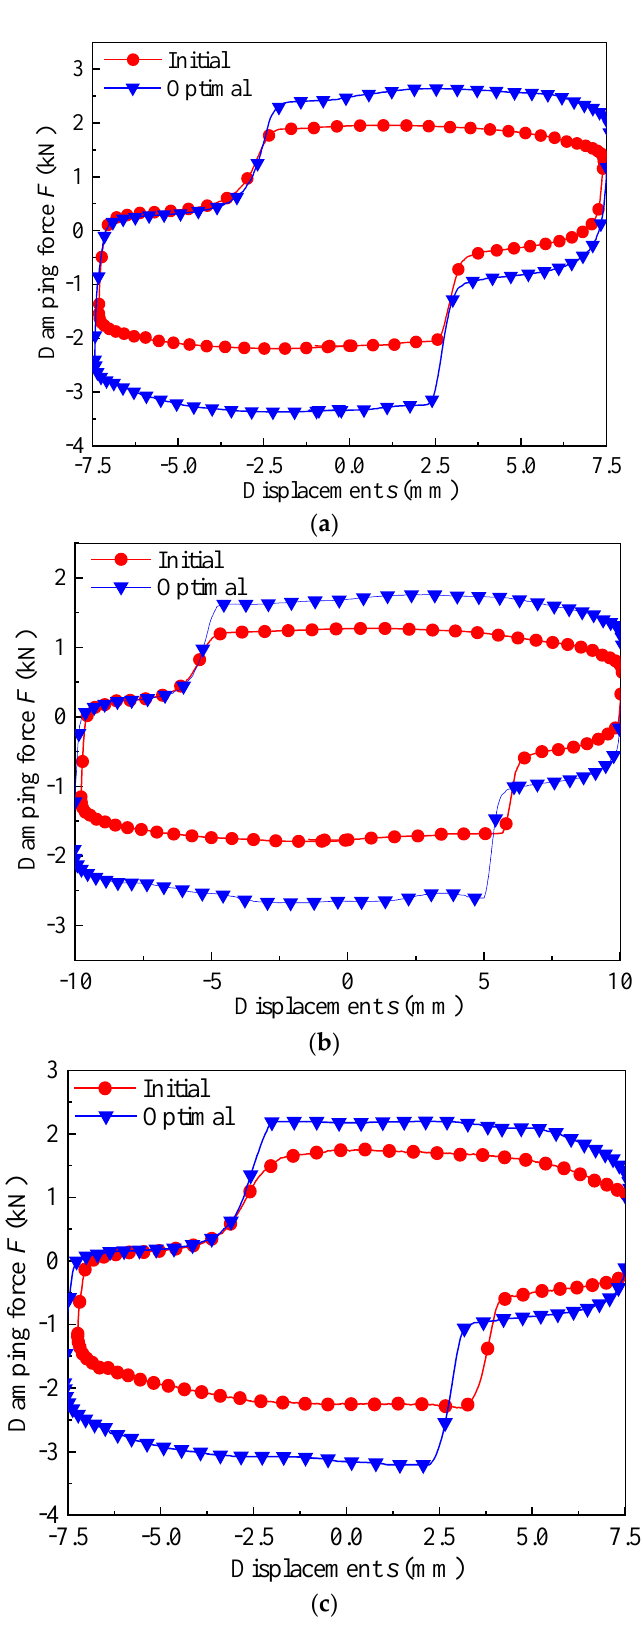
Figure 32. Comparison of damping force of initial and optimal MR valve control cylinder system: ( a ) applied current of 1 A, ( b ) amplitude of 10 mm, and ( c ) frequency of 0.75 Hz.